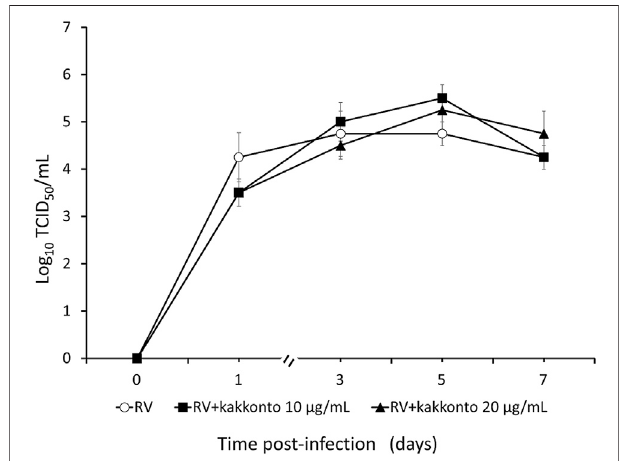
FIGURE 2 | Time course of viral release into supernatants of HNE cells infected with RV14 and treated with kakkonto (10 μ g/ml, closed squares), kakkonto (20 μ g/ml, closed triangles), or medium only (open circles). Results are presented as the mean ± standard error from four subjects.